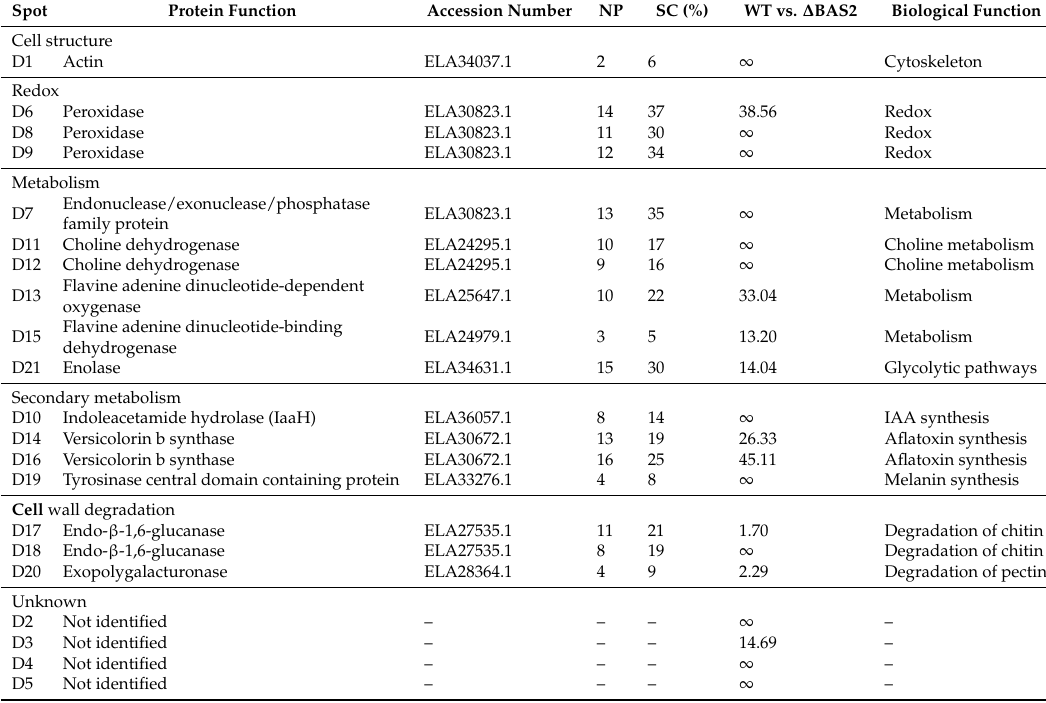
Table 1. Proteins identified by quadrupole-time-of-flight tandem mass spectrometry. The accession numbers of the proteins of C. gloeosporioides Nara gc5, which showed the most homology to the protein spots, are listed. NP, number of matched peptides; SC, amino acid sequence coverage for identified proteins; WT vs. ∆ BAS2, average fold change of relative abundance of specific spot of WT versus ∆ BAS2 from three biological repeats; ∞ , corresponding spot appeared in WT but not in ∆